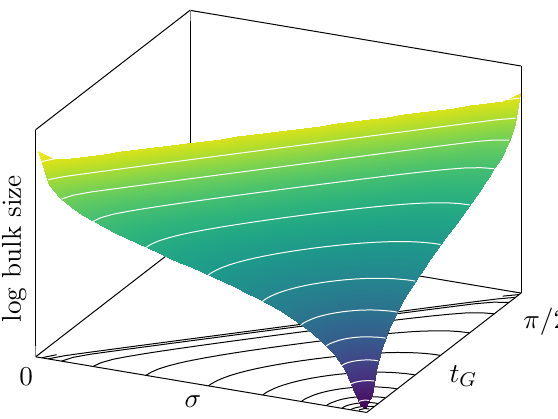
Figure 6. Bulk size in the limit cosh (cid:26) 1 =(cid:15) (in arbitrary size units; note that in this limit, (cid:28) the bulk fermion size of both components has the same behaviour). The plot is shown in global coordinates (cid:27); t G over the part of the Rindler wedge t R > 0. As discussed in section 4.3, this